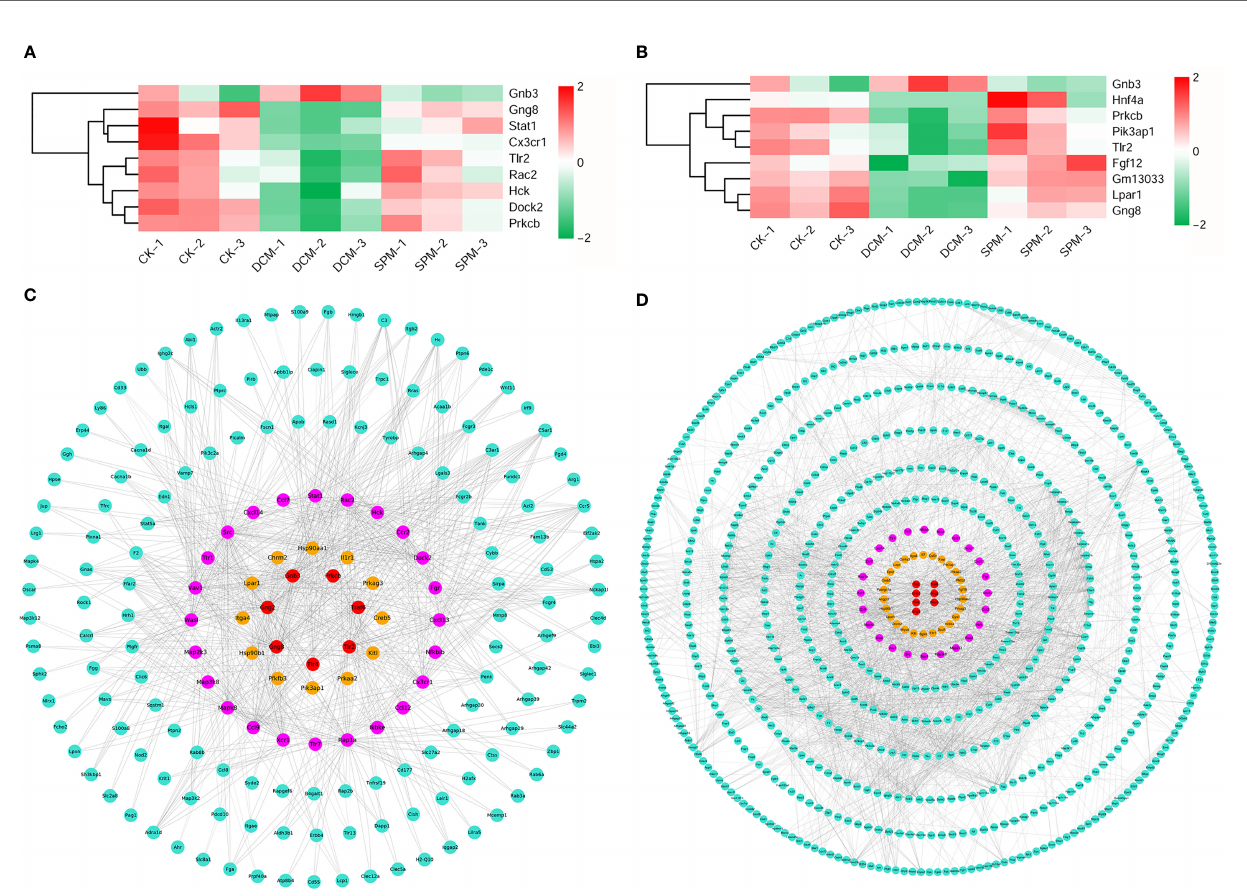
FIGURE 4 | Analysis of the candidates of classical immunity and signal transduction pathways involved in DCM. (A) Heat map shows the hierarchical clustering of DEGs in chemokine signaling pathway, B-cell receptor signaling pathway, and Toll-like receptor signaling pathway. (B) Gene interaction network analysis of the above candidates between SPM and DCM. The candidates in chemokine signaling pathway, B-cell receptor signaling pathway, and Toll-like receptor signaling pathway are colored in pink, yellow, and red, respectively, and other genes are colored in turquoise. (C) Heat map shows the hierarchical clustering of DEGs in the PI3K-Akt signaling pathway, NF-kappa B signaling pathway, and AMPK signaling pathway. (D) Gene interaction network analysis of the above candidates between SPM and DCM. The candidates in PI3K-Akt signaling pathway, NF-kappa B signaling pathway, and AMPK signaling pathway are colored in yellow, pink, and red, respectively, and other genes are colored in